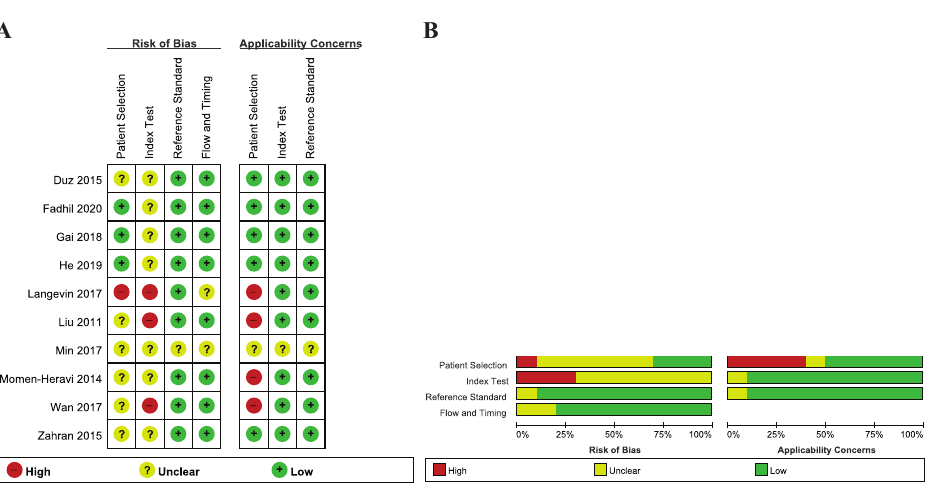
Figure 2. ( A ) Risk of bias and applicability concerns graph. Review author judgements about each domain are presented as percentages across the included studies; ( B ) Risk of bias and applicability concerns summary. Review author judgements about each domain for each study